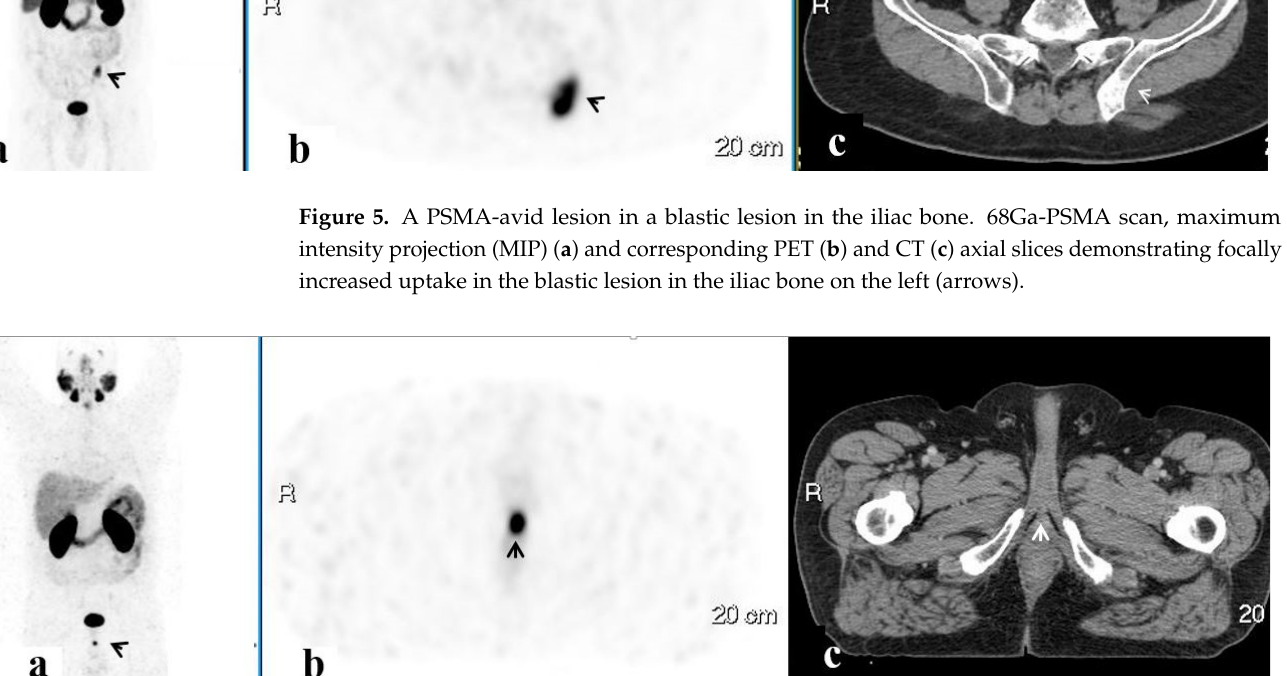
Figure 6. 68Ga-PSMA scan, maximum intensity projection MIP ( a ) and corresponding PET ( b ) and CT ( c ) axial slices demonstrating focally increased uptake at the base of the penis (arrows).